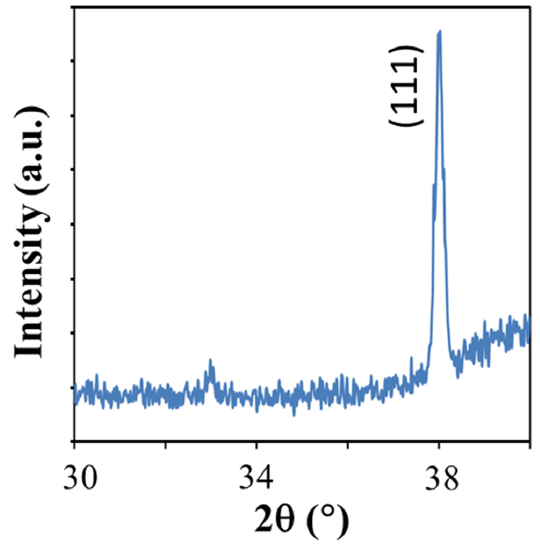
Figure 5. Grazing ‐ angle X ‐ ray diffraction spectra of 2D crystal of Pt. Figure 5. Grazing-angle X-ray diffraction spectra of 2D crystal of